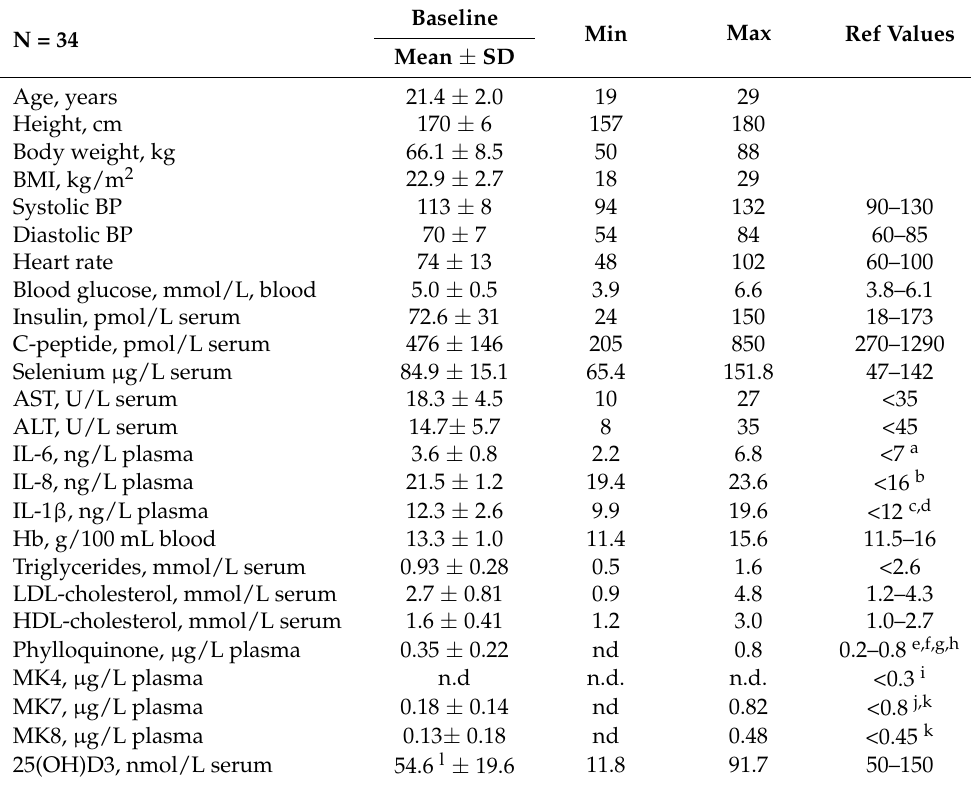
Table 2. Baseline characteristics of 34 participants; anthropometric values and serum analyses, mean values at baseline, standard deviations (SD), min and max values and reference ranges. Baseline Min Max Ref Values N = 34 Mean ± SD Age, years 21.4 ± 2.0 29 Height, cm 170 ± 6 157 Body weight,